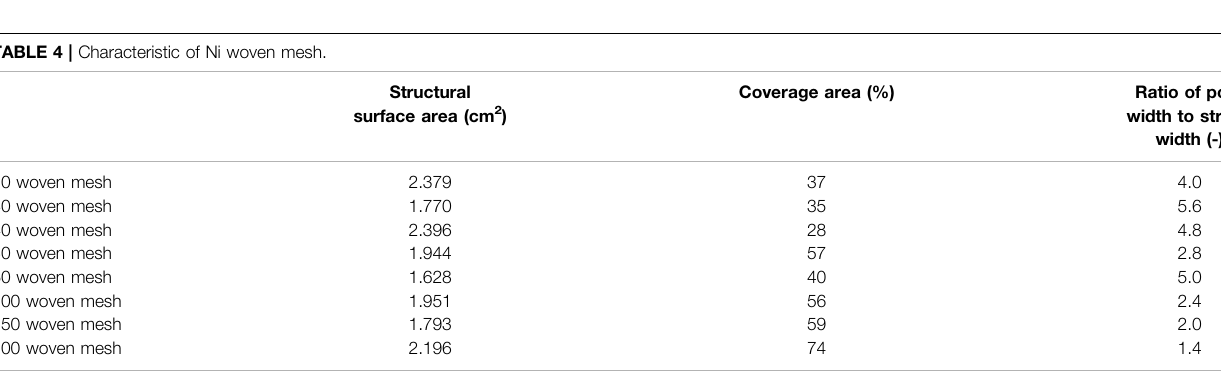
TABLE 4 | Characteristic of Ni woven